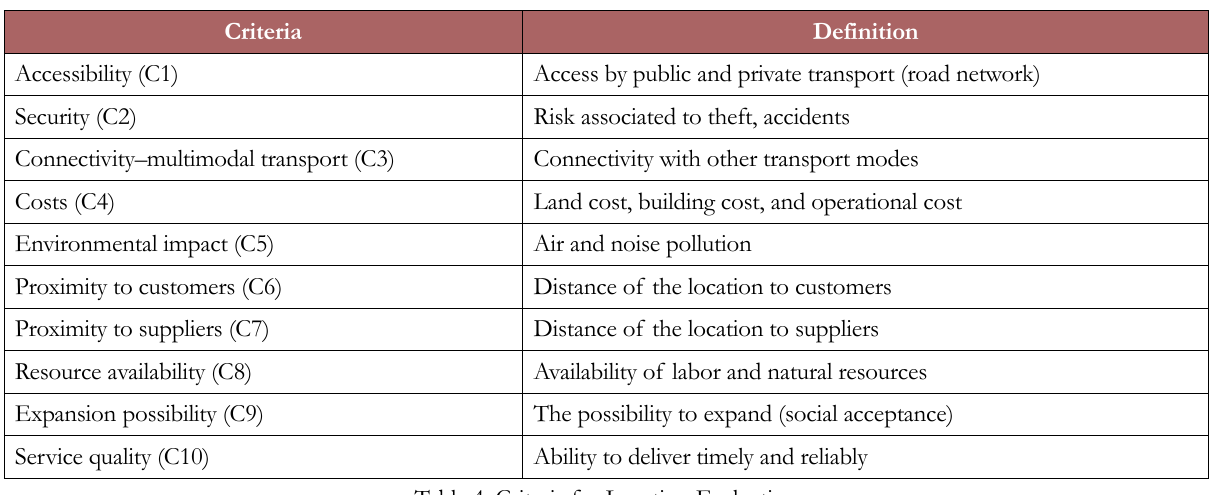
Table 4. Criteria for Location Evaluation